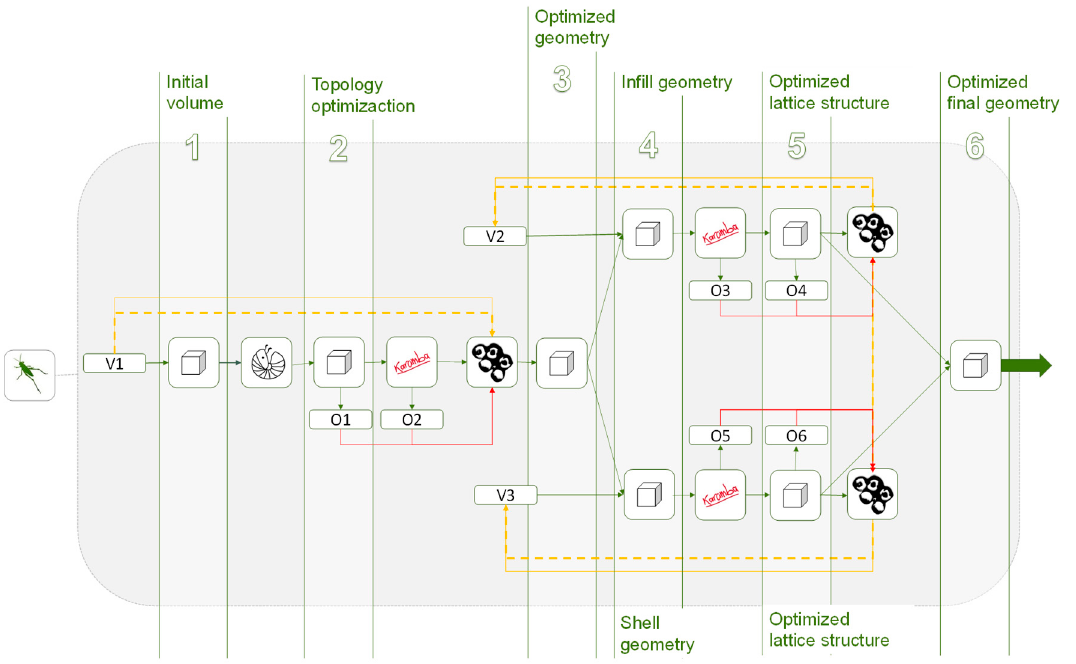
Figure 18. Hierarchical methodology with more than one multi-objective optimization algorithm in which the optimization problem is decomposed into 3; initial volume, infill structure, and wireframe shell.